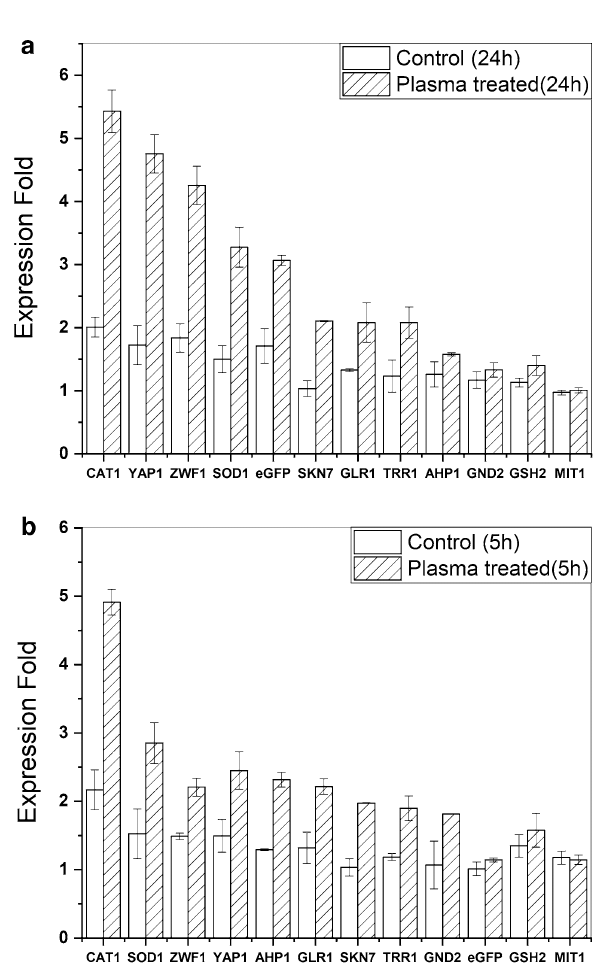
Figure 7. mRNA expression was analyzed after a. 5 h, b. 24 h after plasma treatment. The error bars are standard